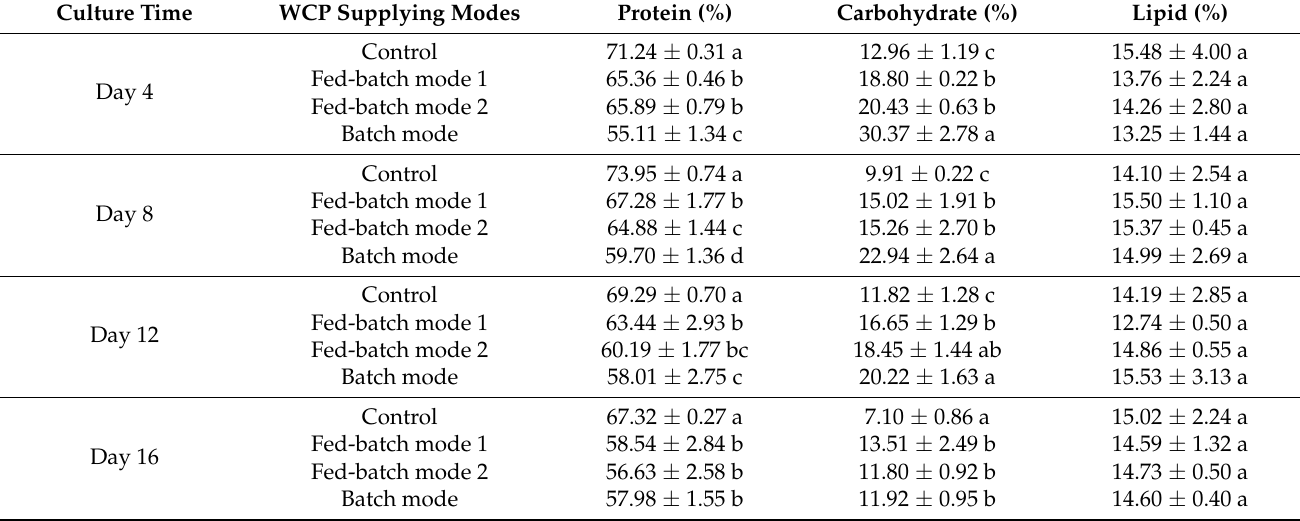
Table 4. Main biochemical components content of Arthrospira platensis as affected by the caprolactam wastewater supply modes. Data with different letters indicate significant differences ( p < 0.05) between the control and